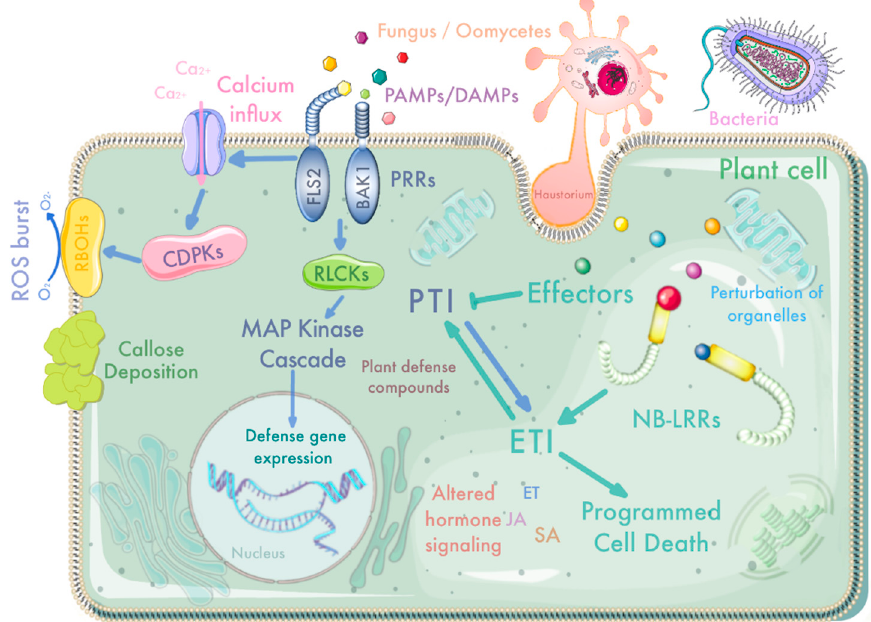
Figure 1. Plant immune system. PRRs of plant cells recognize PAMPs and trigger the first layer of plant immune response PTI, which triggers responses such as calcium inward flow and reactive oxygen species burst. Pathogens produce effectors to inhibit PTI, and plant R proteins, such as NB-LRR proteins, are activated by effectors to produce the second layer of immune response ETI, which disrupts effectors and causes cell death.